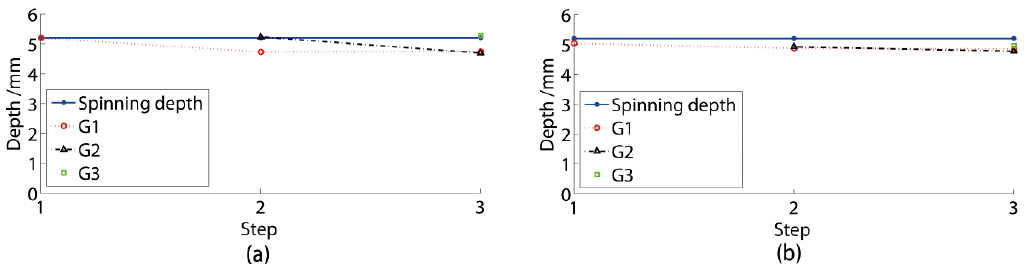
Figure 9. Groove depth during spinning. ( a ) Numerical; ( b ) experimental.